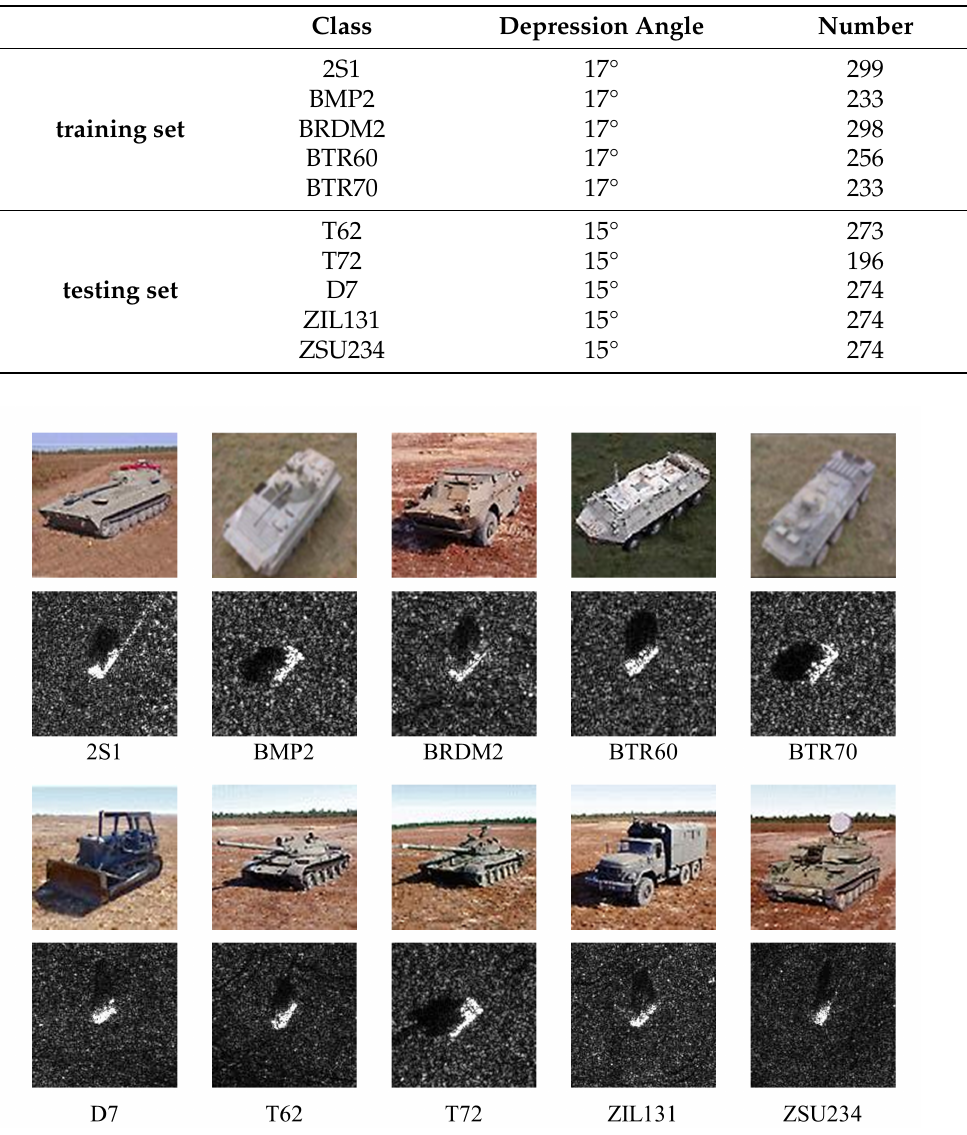
Table 2. Dataset division of MSTAR.